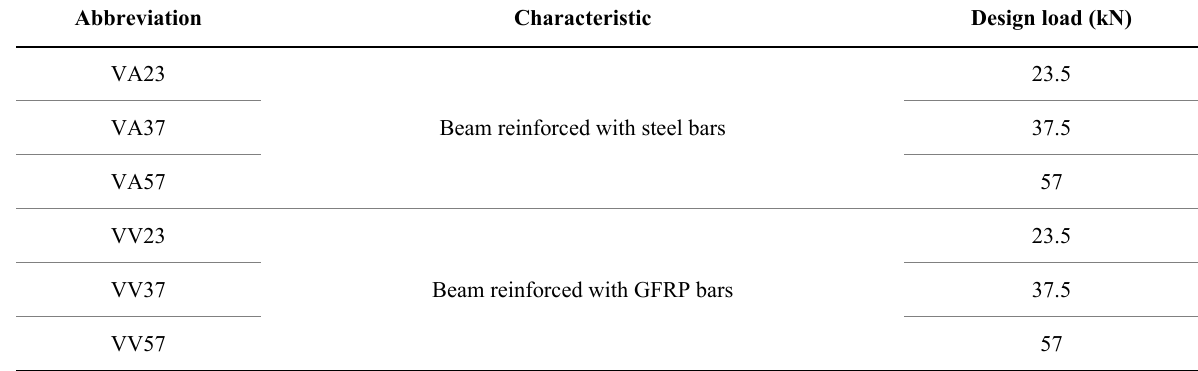
Table 1. Characteristics of the beams.